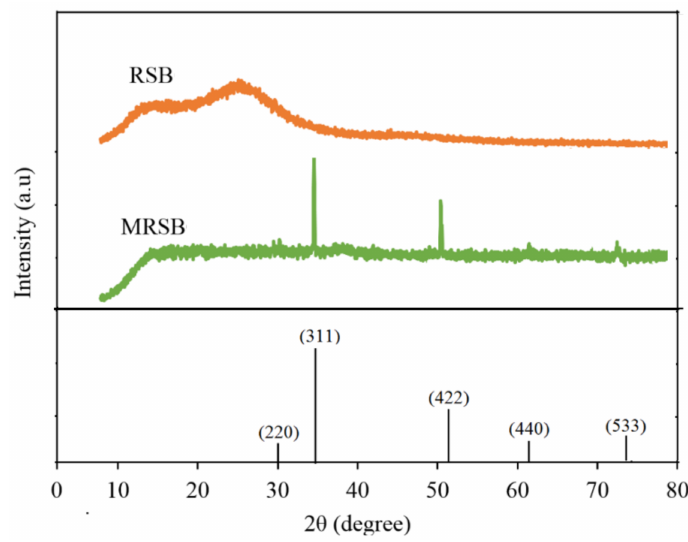
Figure 3. XRD patterns of RSB and MRSB.